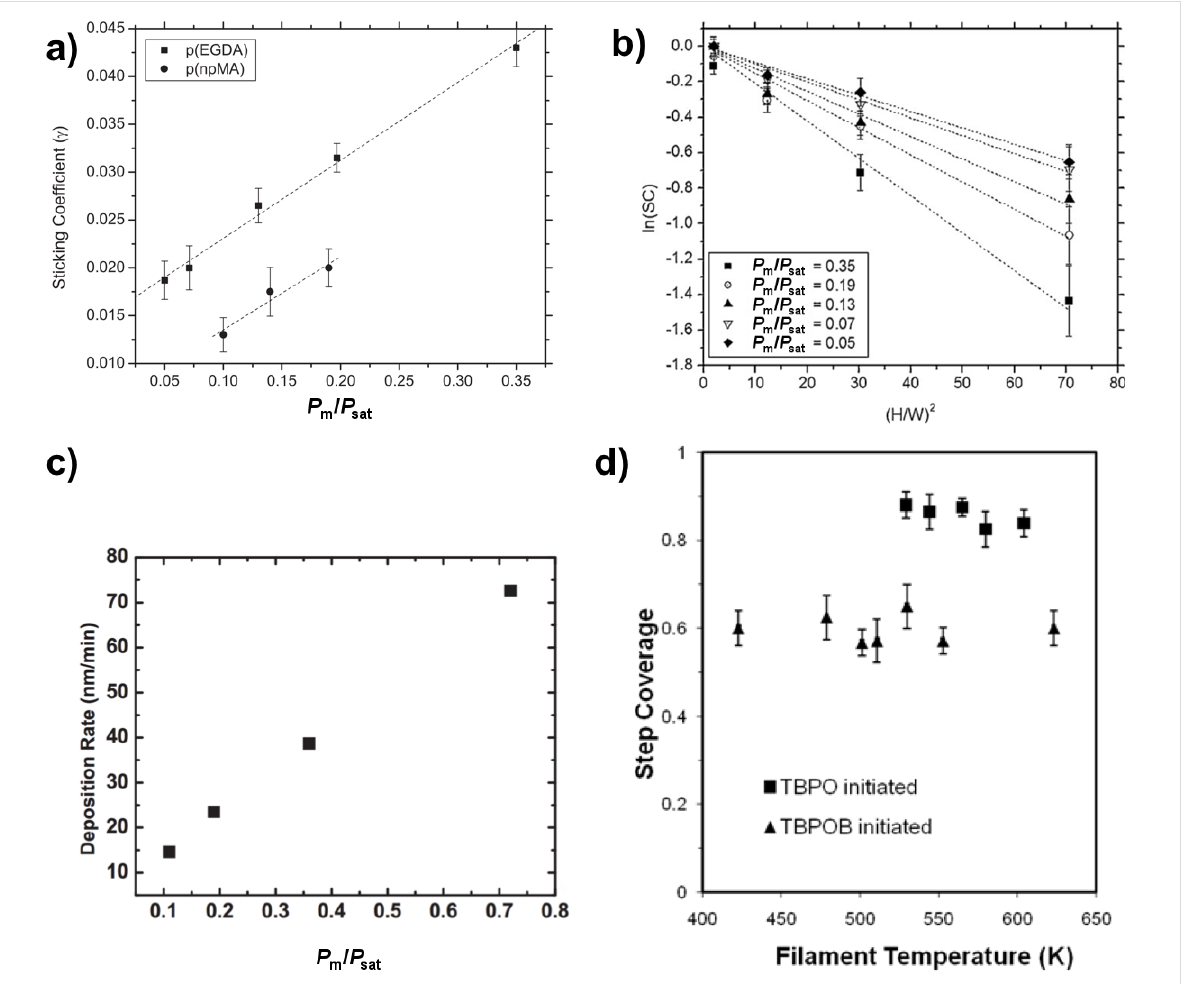
Figure 4: a) Sticking coefficients of tert -butoxy initiator radicals as function of P m / P sat and monomer type where EGDA, a di-acrylate monomer, has a higher Γ than npMA, a methacrylate monomer, due to the presence of a second reactive moiety. b) Step coverage as a function of trench aspect ratio at varying P m / P sat values. c) iCVD deposition rate as function of P m / P sat . d) Step coverage as a function of filament temperature and type of initiator. Parts a) and b) reprinted with permission from [25], copyright 2010 John Wiley and Sons. c) Reprinted with permission from [21], copyright 2008